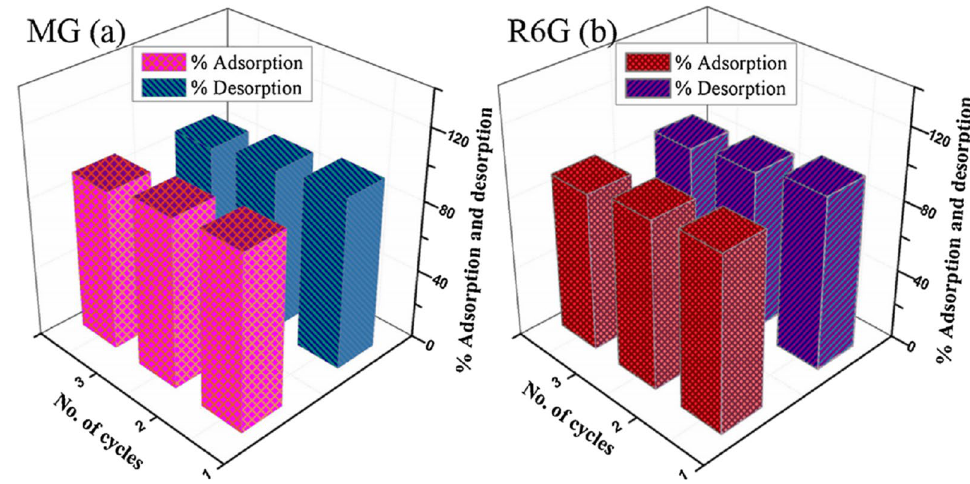
Fig. 23 Adsorption and desorption of MG and R6G on HATF-SO